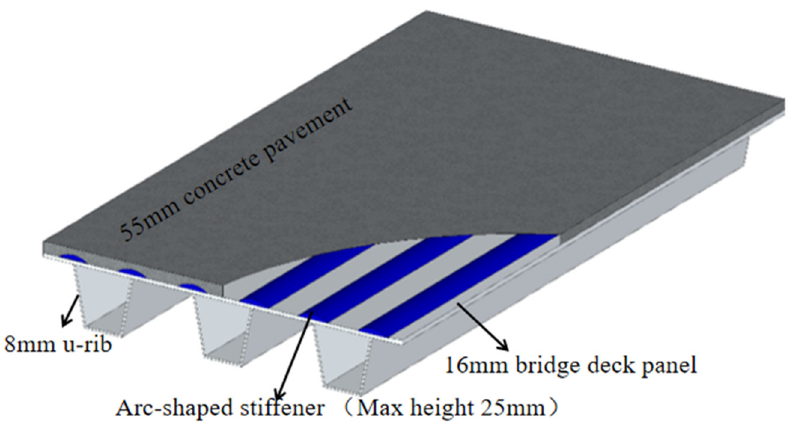
Figure 1. Schematic diagram of OSD with arc-shaped stiffener.